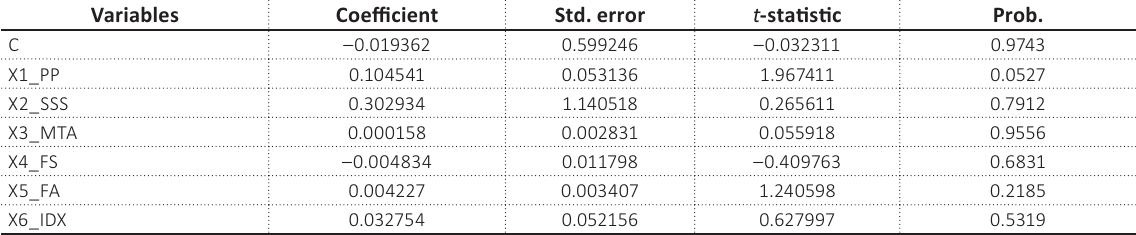
Table A4. Heteroskedasticity test by using Glejser test